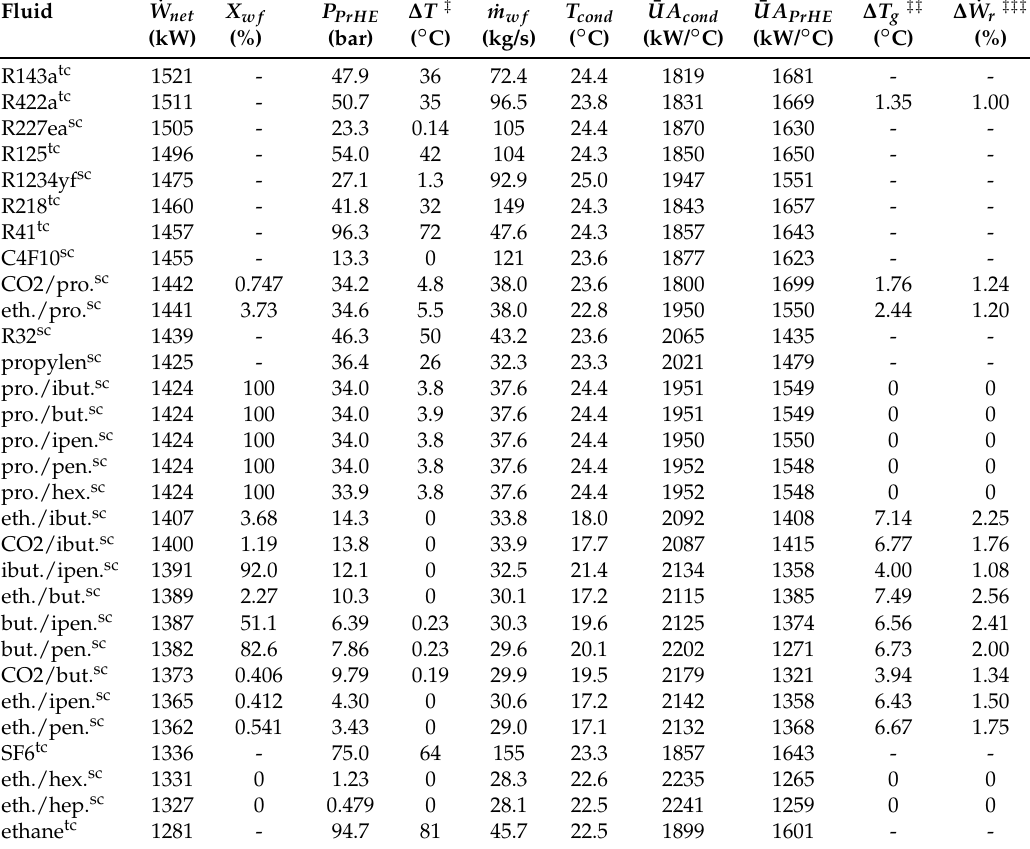
Table 5. Fluid selection and optimization based on fixed values of ¯ UA tot = ¯ UA PrHE + ¯ UA cond = 3500 kW/ ◦